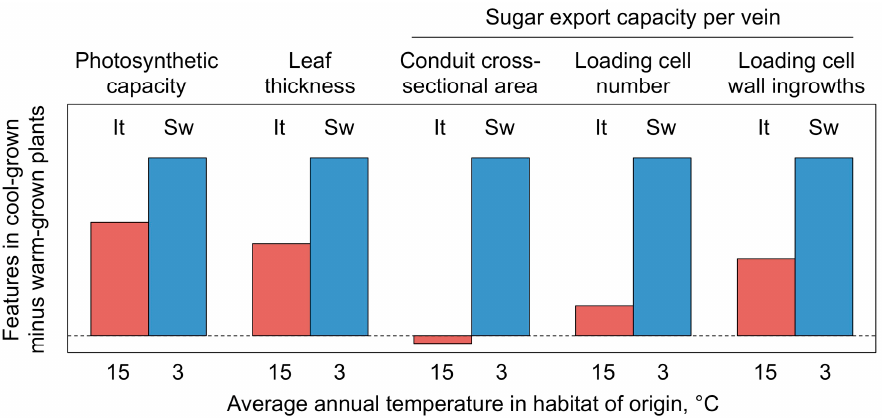
Figure 7. Differences in leaf and minor-vein features of Italian (It) and Swedish (Sw) ecotypes of A. thaliana grown at cool (14 °C) versus warm (36 °C) leaf temperatures under a moderate light intensity of 400 µmol photons m − 2 ·s − 1 , in relation to average annual temperatures of the locations from which the ecotypes originated. Based on data from Adams et al. [75].